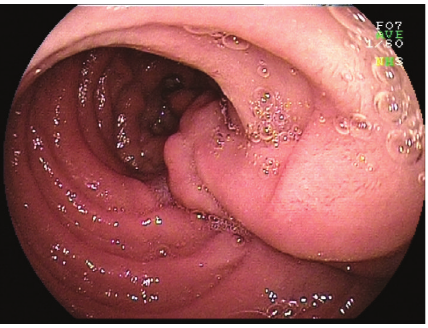
Figure 1: Jejunal lipoma. Figure 2: Jejunal